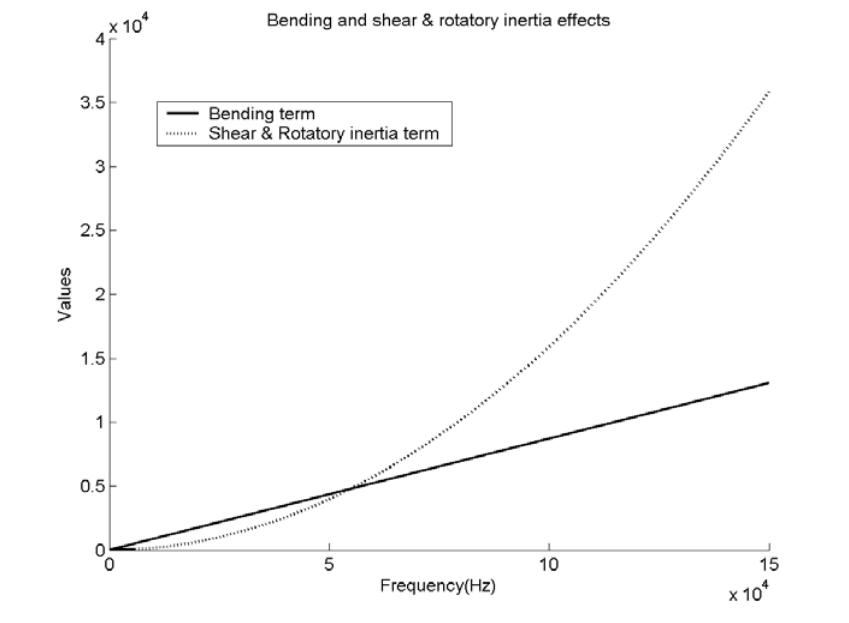
Fig. 1. The effects of bending, shear and rotatory inertia in corrected flexural wavenumber of rectangular Timoshenko beam (steel, B × H = 0.05 m × 0.05 m, f c = 31746 Hz); ‘—’ is bending term and ‘---’ is shear and rotatory inertia term.